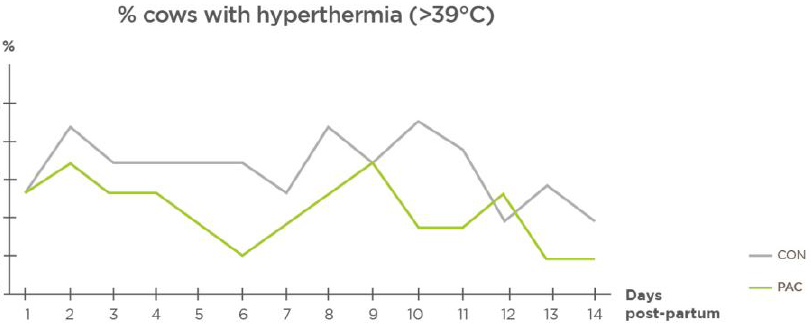
Figure 4. Effect of plant bioactive compounds on cows with hyperthermia within 0–14 days post- partum (%) ( n = 23).